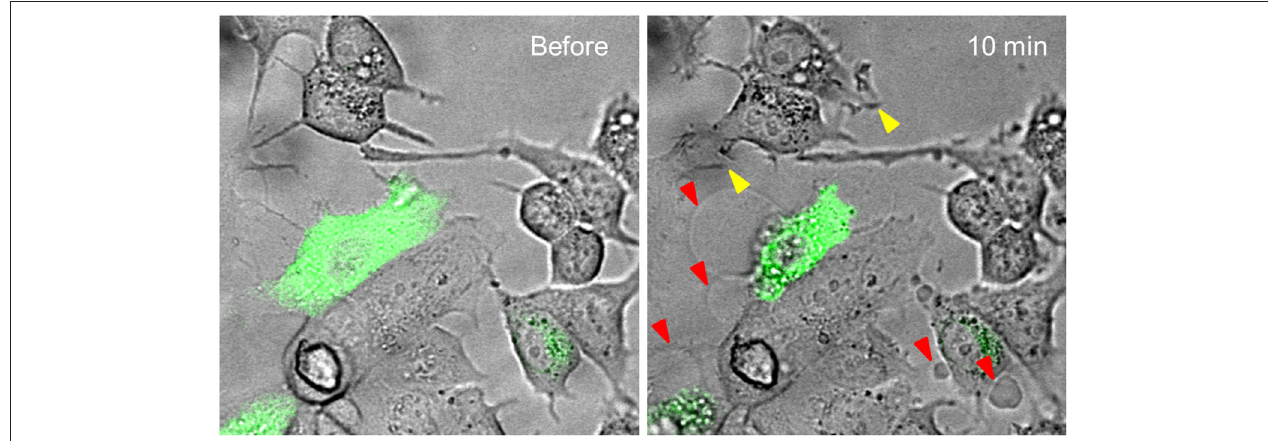
FIGURE 2 | Time-lapse analysis of vanilloid evoked structural changes in MCF7 breast cancer cell line. MCF7 cells were transiently transfected with TRPV1-GFP construct. These show green fluorescence. Cells were treated with 50 µ M CAP. TRPV1-GFP expressing cells, and only these cells, blow blebs during a 10-min period (red arrowheads). MCF7 cells also endogenously express low levels of TRPV1 channels. This level is not enough to induce bleb formation, but some MCF7 cells produce invadopodium, an ameboid structure promoting cancer cell invasion, in response to CAP treatment (yellow arrowheads). The original experiment was published in 2016 ( Pecze et al.,